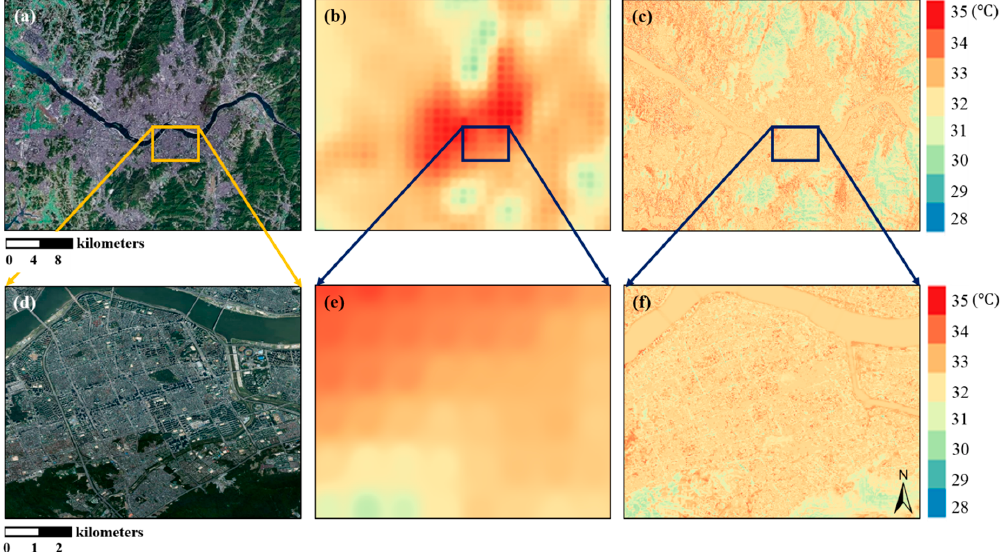
Figure 9. Spatial accuracy evaluation for the heatwave period (forecast day: August 4, 2017, 06:00 UTC). ( a ) Map of Seoul; ( b ) local data assimilation and prediction system (LDAPS) temperatures across Seoul; ( c ) urban meteorological information system (UMIS) temperatures across Seoul; ( d ) map of the Gangnam district; ( e ) LDAPS temperatures across the Gangnam district; ( f ) UMIS temperatures across the Gangnam district.